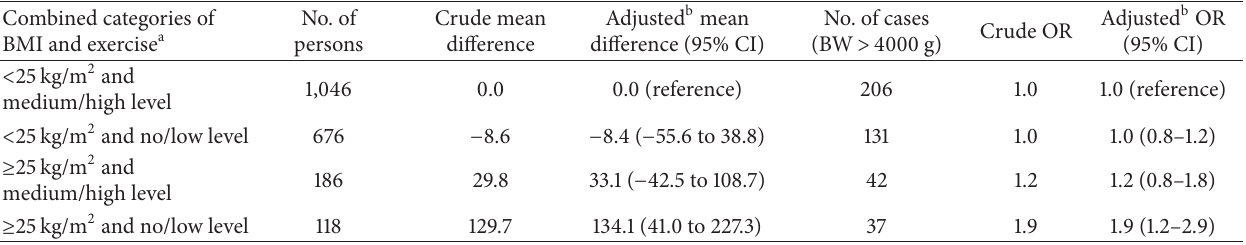
Table 4: Maternal pre-pregnancy body mass index (BMI) and leisure time physical exercise related to mean offspring birth weight from linear regression and odds ratio (OR) from logistic regression for a macrosomic infant (i.e., birth weight > 4000 g). Combined categories